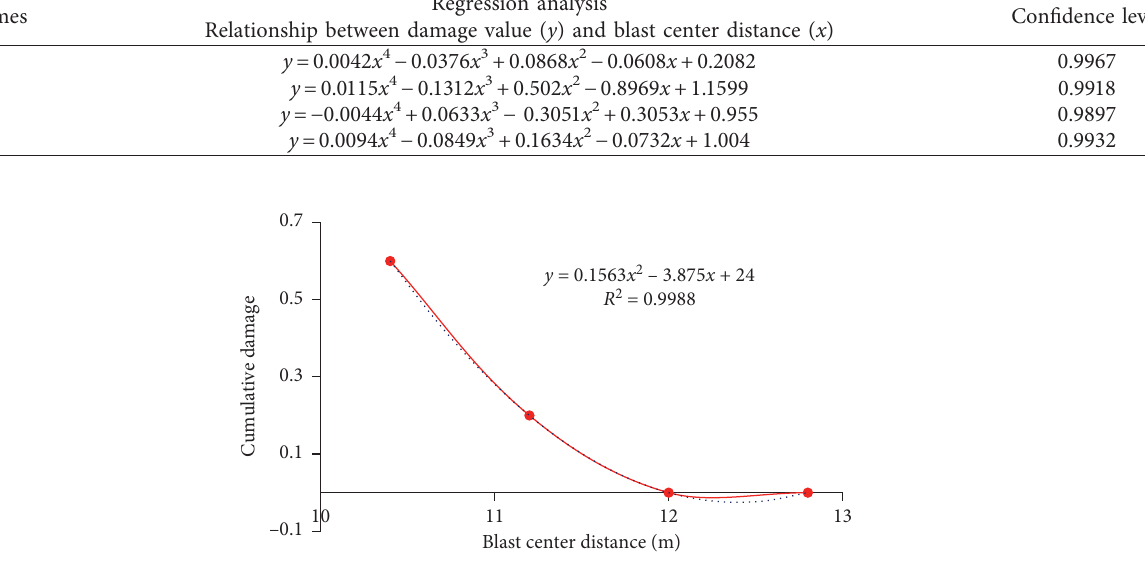
Figure 21: The variation law of cumulative damage of rock anchor beam concrete perpendicular to the axis of the powerhouse with the blast center distance (the 2 nd blast). Table 6: The relationship between the damage value of some unit monitoring points of the rock anchor beam along the axis of the powerhouse and the blast center